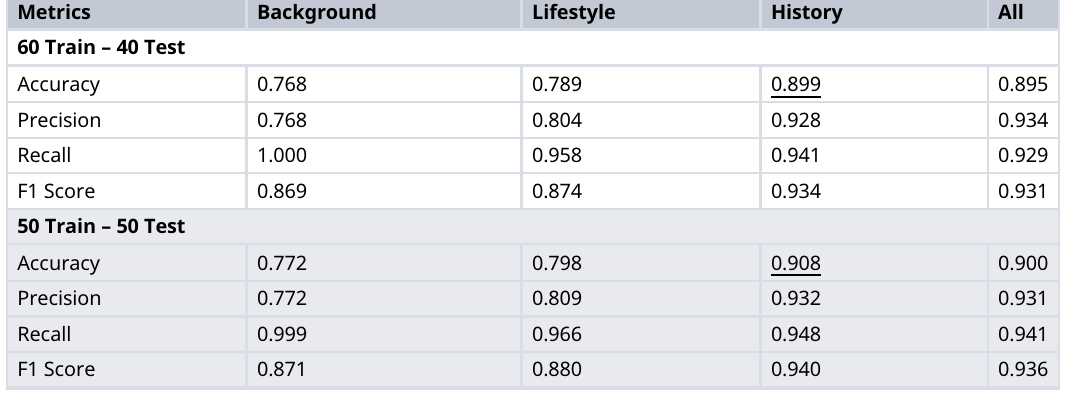
Table 6. SVM (Binary